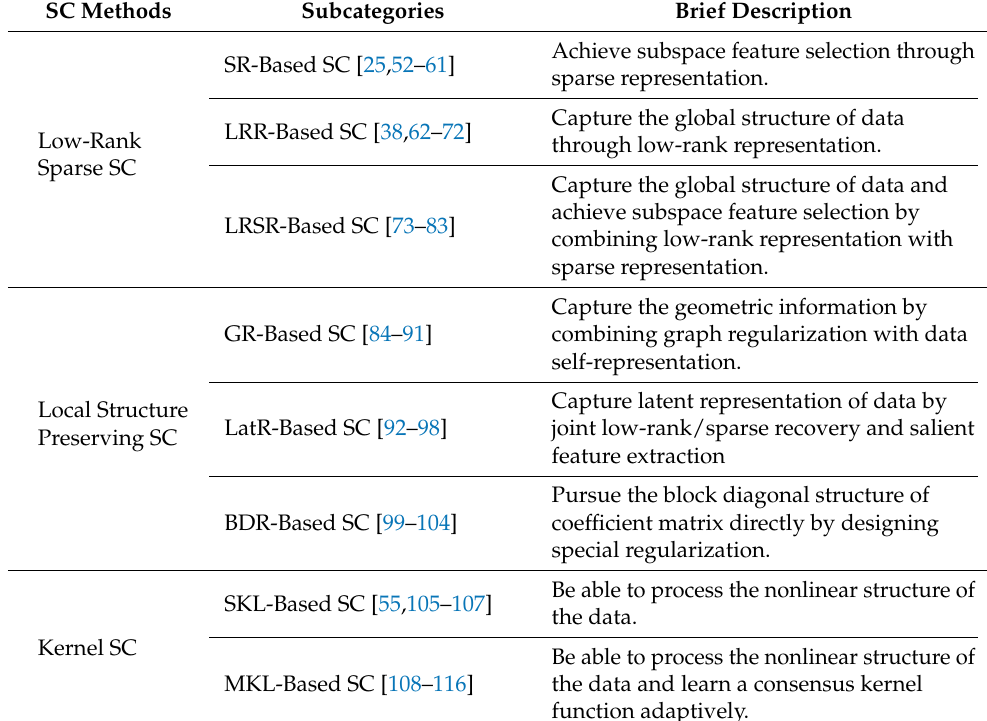
Table 1. A brief summary of SC